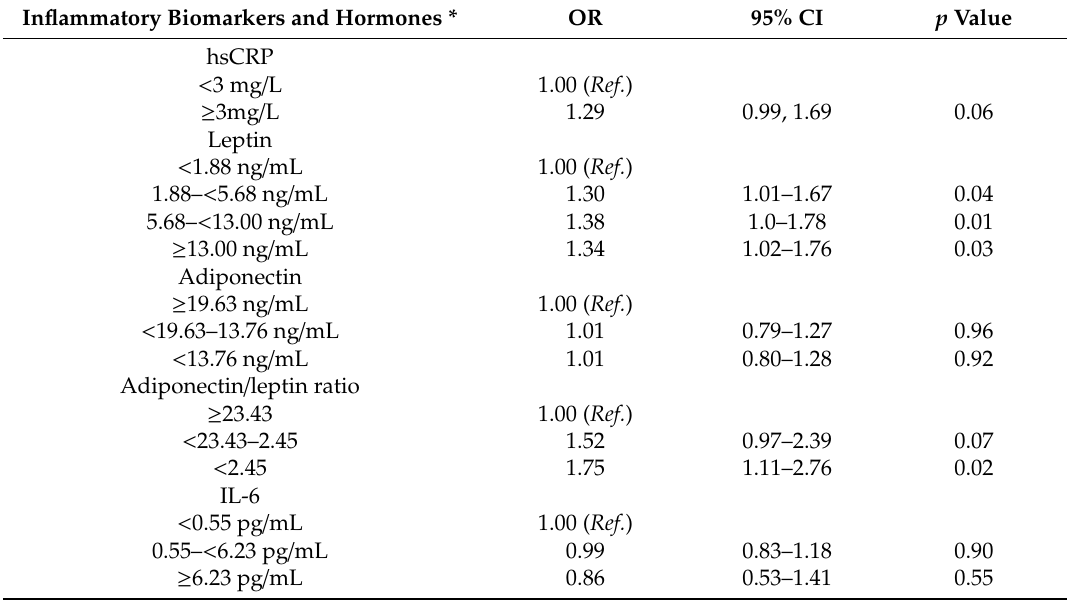
Table 3. Association between C-DII and inflammatory biomarkers and hormones at 11 years. Inflammatory Biomarkers and Hormones